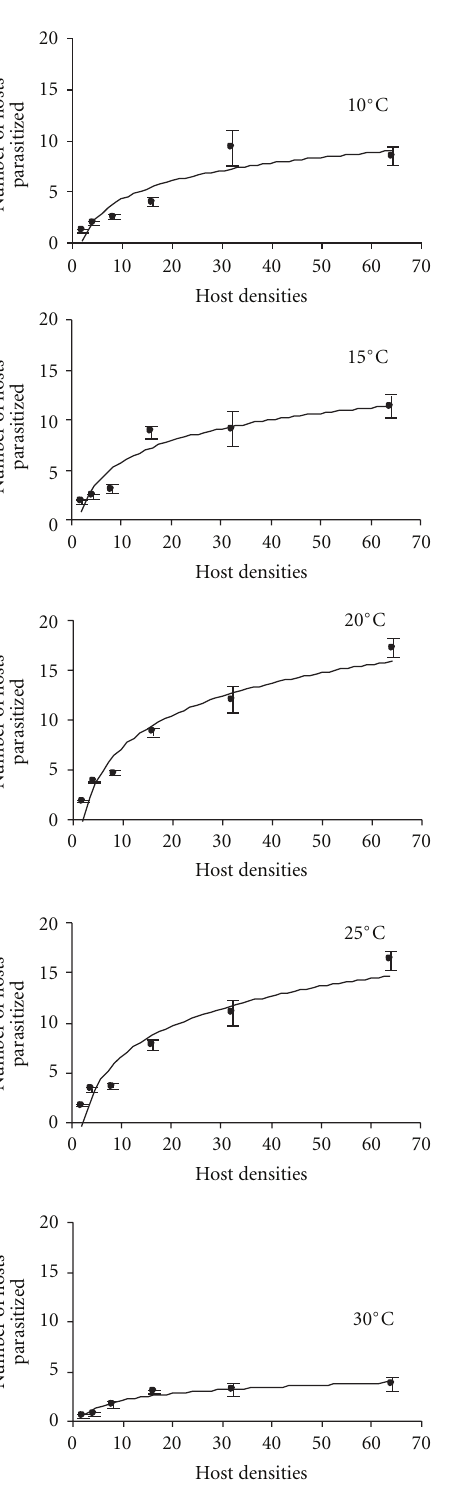
Figure 2: Type II-functional response of Praon volucre on di ff erent densities of second-instar nymphs of Sitobion avenae at various constant